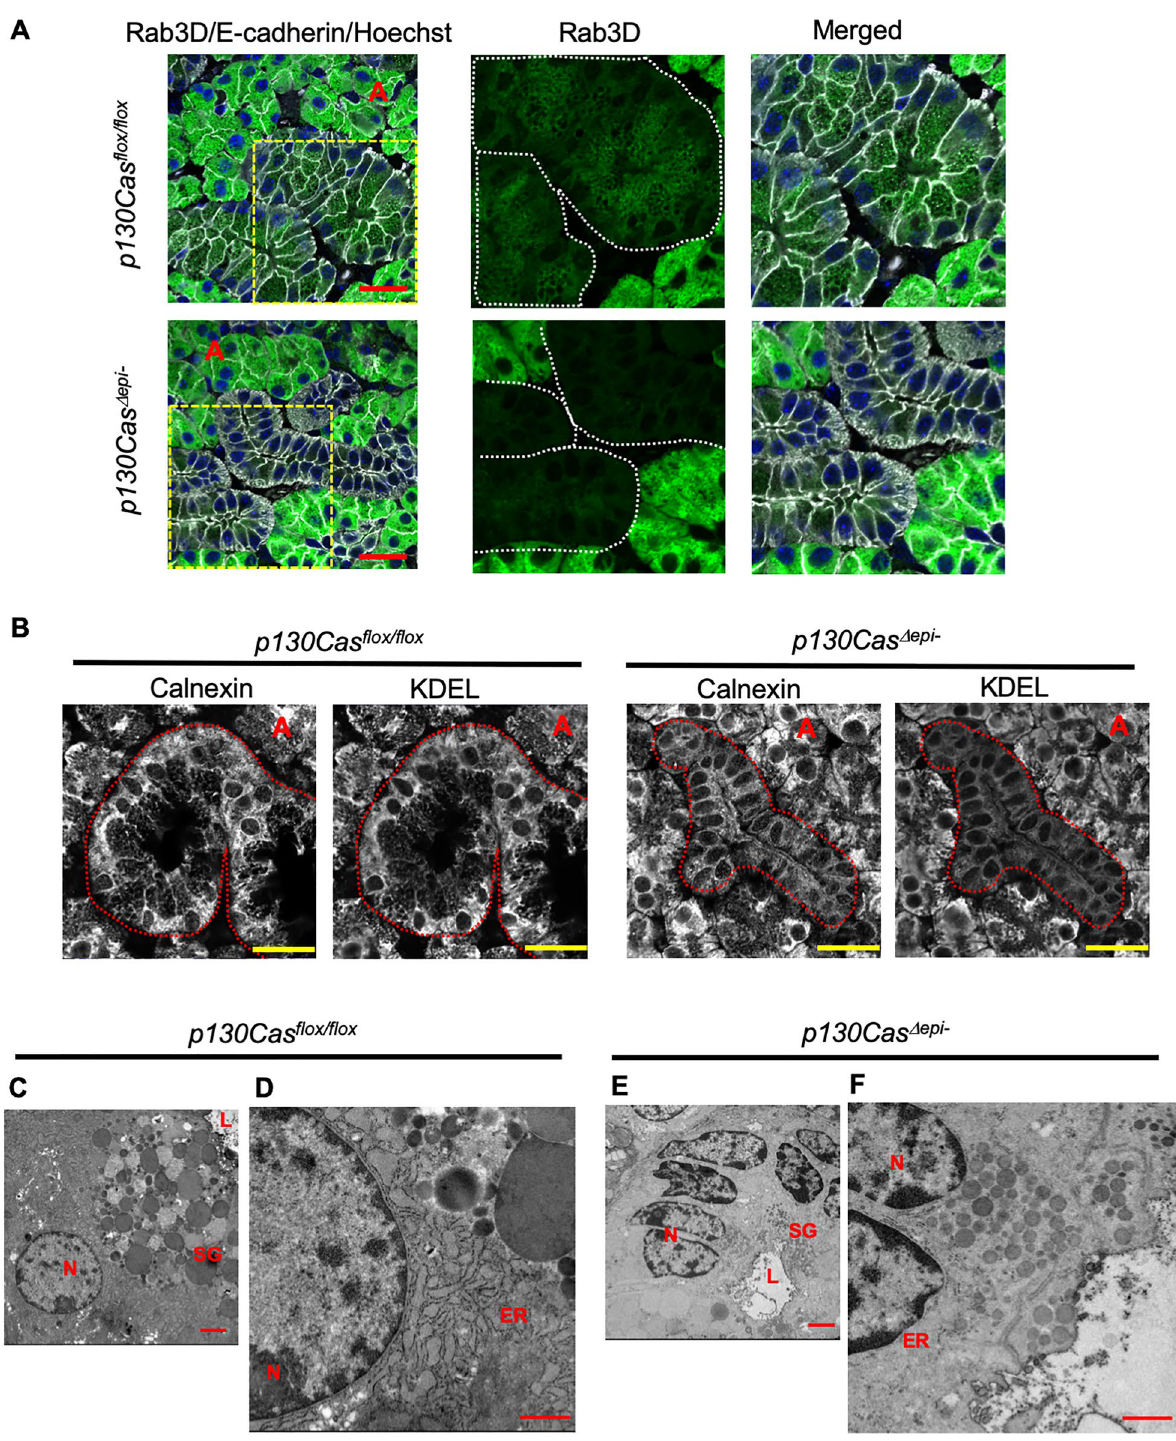
Figure 7. ER-Golgi network was less developed in p130Cas Δepi- mice. ( A ) Representative immunofluorescence staining images of SMG paraffin sections using anti-Rab3D (green) and anti-E-cadherin (grey). Yellow boxed regions are shown as magnified images. Areas surrounded by white dotted lines indicate GCTs. ( B ) Representative immunofluorescence staining images of SMG paraffin sections using anti-calnexin (grey), and anti-KDEL (grey). Areas surrounded by red dotted lines indicate GCTs. Nuclei were counterstained using Hoechst 33,342. “A” indicates acinar. Scale bars = 25 µm. ( C – F ) Representative images of transmission electron microscopy of GCT in male p130Cas flox/flox and p130Cas Δepi- mice. Nuleus (N), endoplasmic reticulum (ER), secretory granules (SG), lumen (L). Scale bars = 2 µm (C, E), 1 µm ( D , F